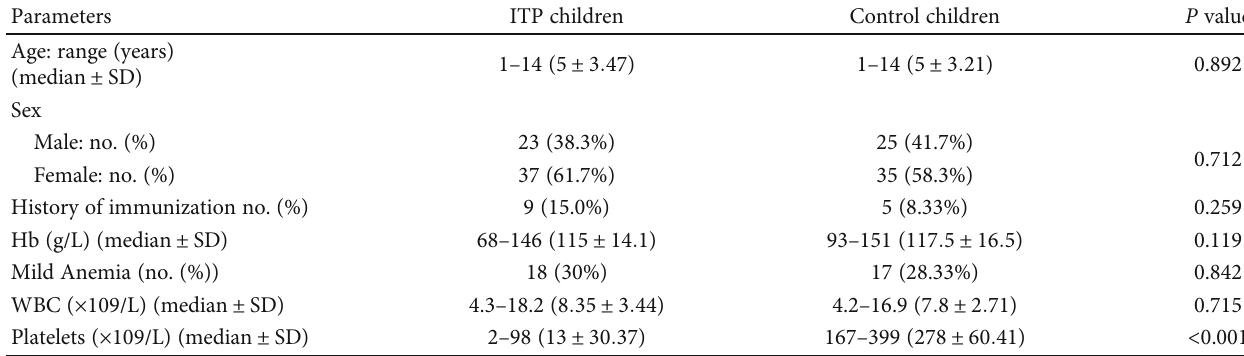
Table 1: Demographic and hematological data of all enrolled patients and controls.